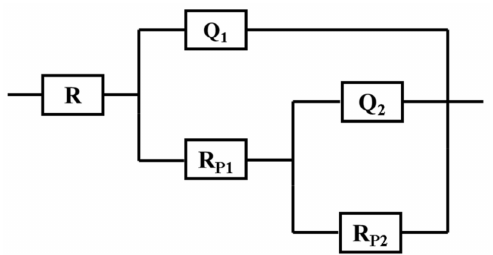
Figure 14. Circuit used to fit the Nyquist plots. (R S ) is solution resistance, (R P1 ) the polarization resistance, (Q 1 ) the constant phase elements, (R P2 ) another polarization resistance, and (Q 2 ) another constant phase element. Table 5. Electrochemical impedance spectroscopy (EIS) parameters obtained by fitting the Nyquist plots for coating containing Aradur